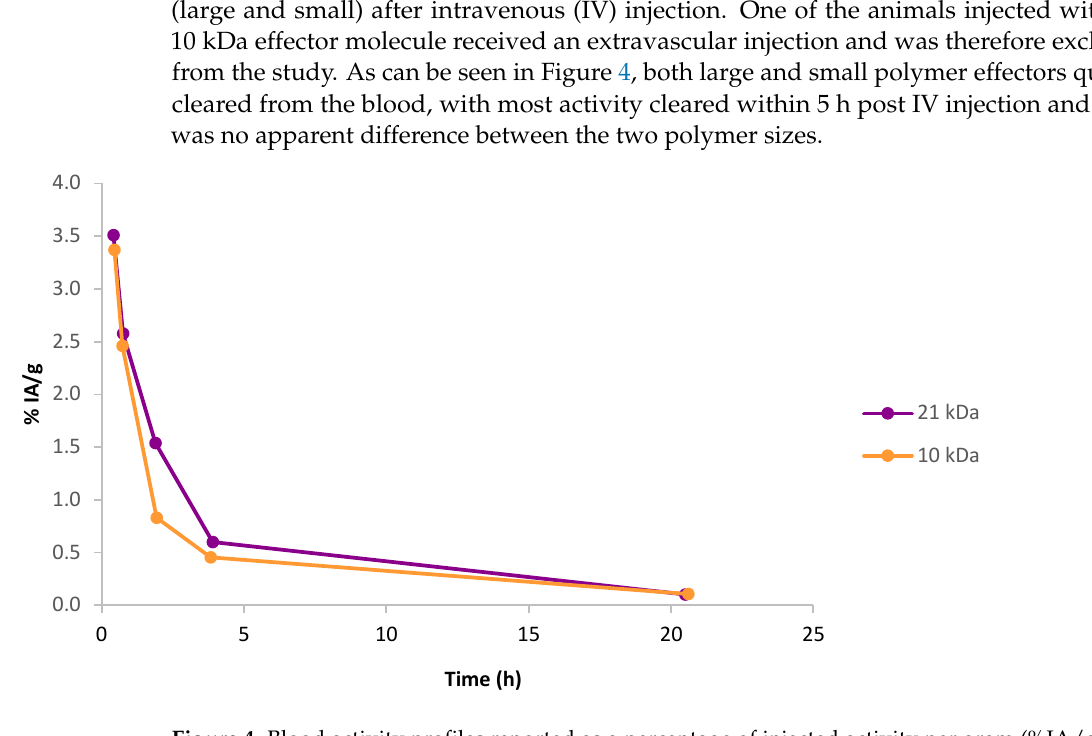
Figure 4. Blood activity profiles reported as a percentage of injected activity per gram (%IA/g) over time in healthy female Balb C mice of two sizes of iodinated effector molecule: 21 kDa (average from n = 2) and 10 kDa ( n = 1) poly-L-lysine. Data can be found in Table S1 in the Supplementary Materials.